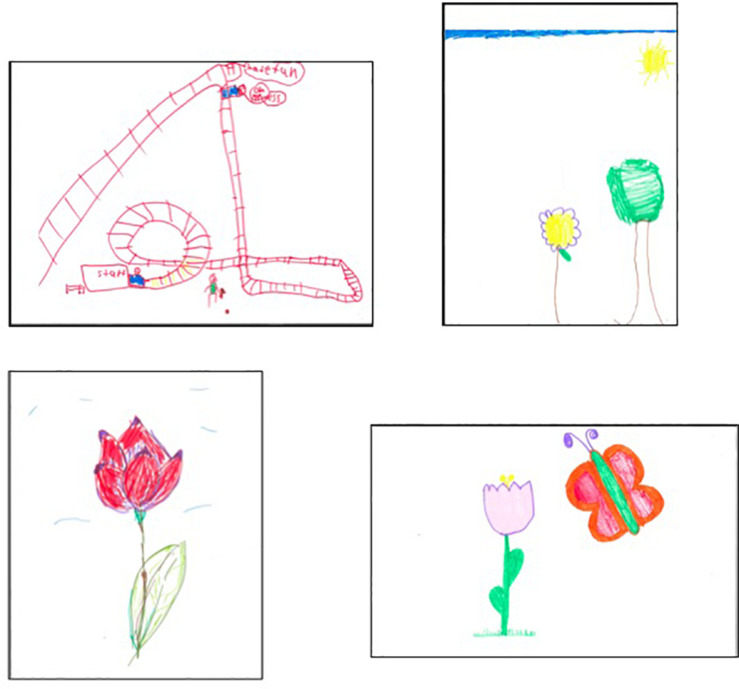
Study 3 sample of children’s drawings. Younger children drew activities they enjoyed (top, left) and items they felt competent drawing (top, right). Older children drew items they observed (bottom, left) or had thought of (bottom, right).